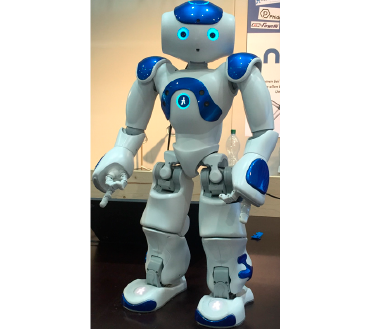
Figure 1. NAO by Aldebaran Robotics. Public domain image from Wikipedia.